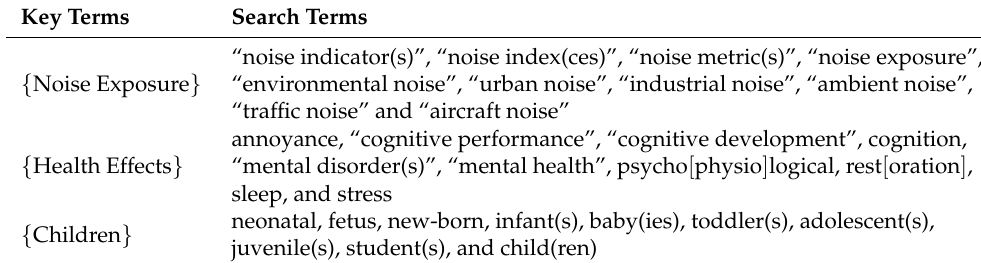
Table 1. Defined key and search terms.